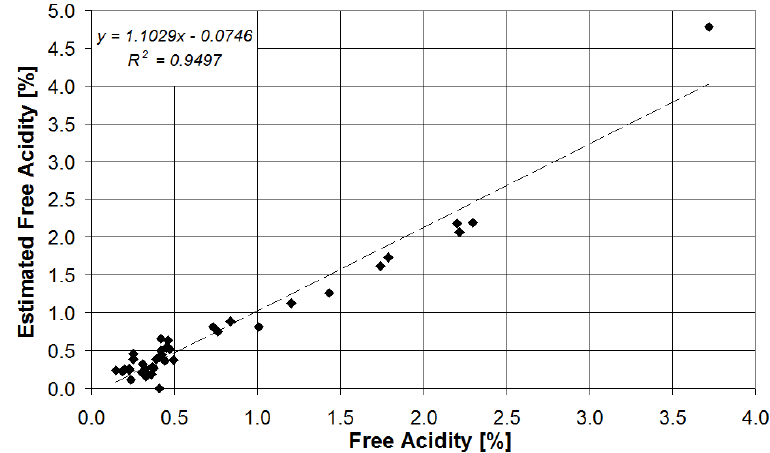
Figure 13. Estimated value of free acidity using the compensation algorithm of Equation (13) and the polynomial function of order 2 plotted vs. the free acidity determined with the reference procedure.